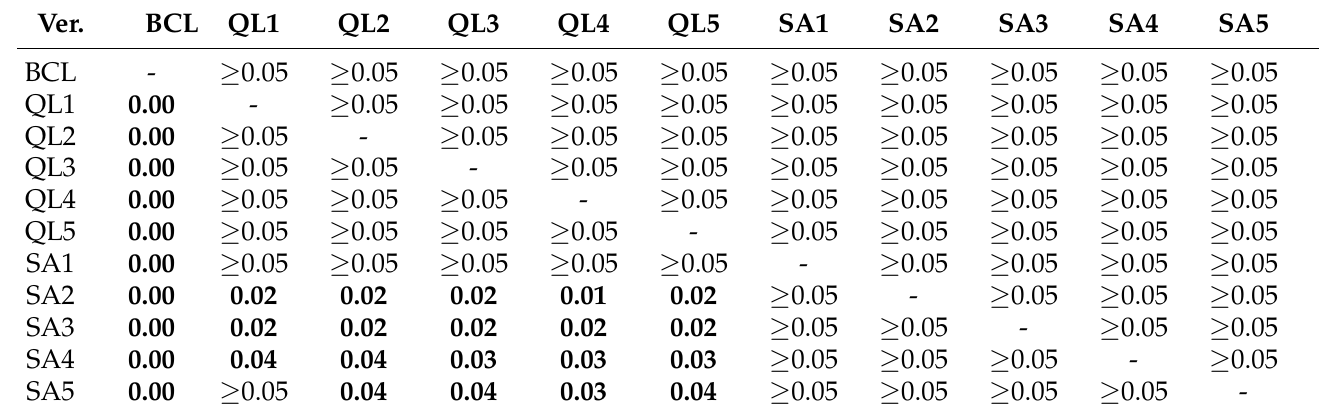
Table 16. The average Wilcoxon–Mann–Whitney test of SCA.